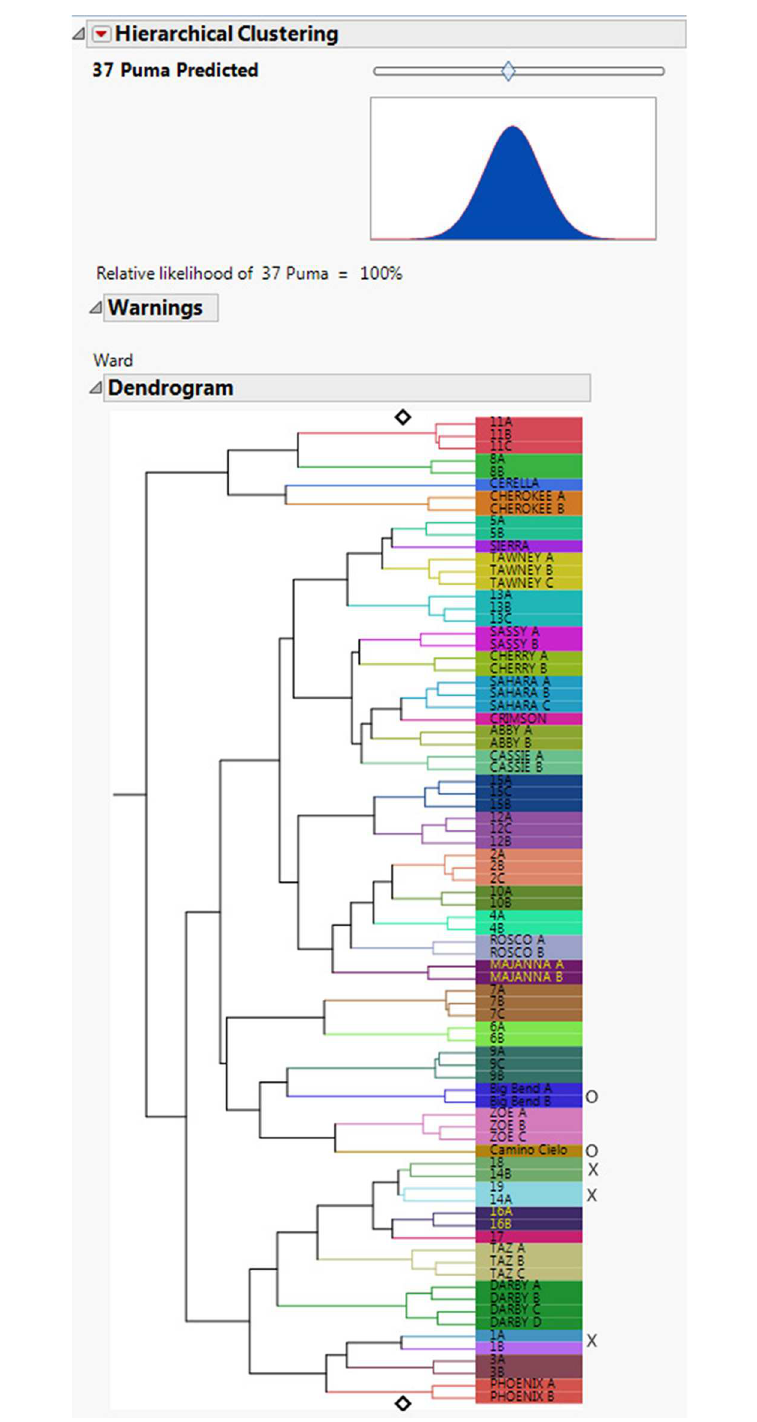
Fig 9. Footprints collected from free ranging animals at Big Bend and Camino Cielo (labeled o) are classified correctly as two individuals different from each other and from all the others in the dataset. Misclassified trails are again indicatedby an